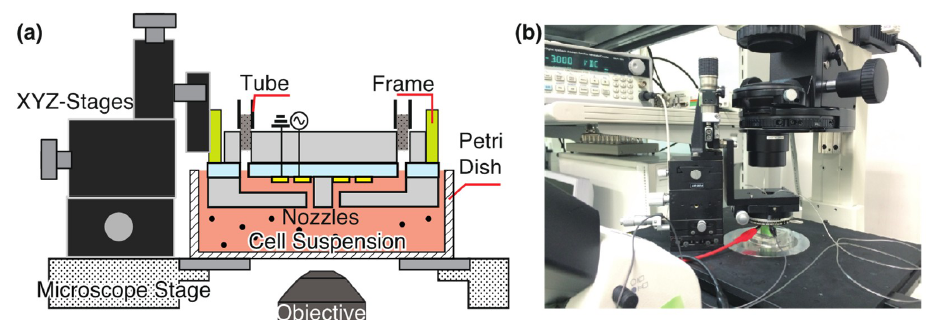
Figure 3. The experimental setup for cell manipulation with a developed nozzle array. ( a ) Schematic and ( b ) picture of the setup. A nozzle array was mounted on the XYZ stage via a 15 mm × 15 mm stainless frame. Electrodes were connected with AC power sources and ground (GND). In the channel of a nozzle array, particle suspension was introduced and HeLa cells were suspended in a petri dish.